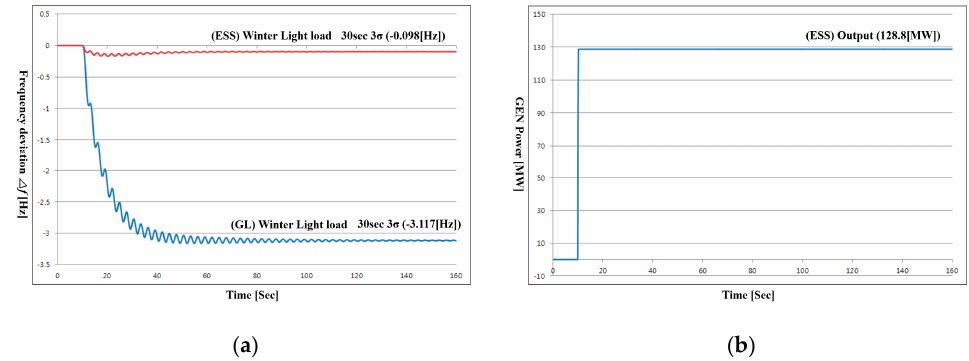
Figure 26. Output analysis of ESS added system: ( a ) Frequency characteristics; ( b ) ESS power output.